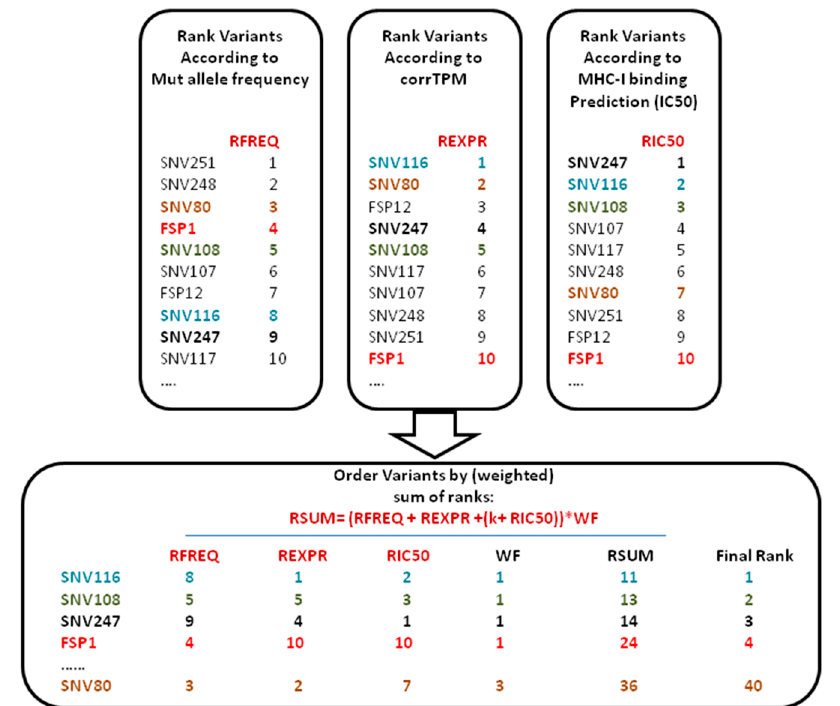
Figure 1. Schematic description of the vaccine-encoded neoantigens unrestricted selection (VENUS) RSUM prioritization method: Schematic description of the ranking procedure applied with VENUS RSUM score. The mutations-encoded neo-peptides are ranked independently three times using three different parameters. For each neo-peptide, the individual ranks are summed and corrected according to weighting factors (k; WF; details in methods) that penalize neo-peptides with a predicted IC50 > 1000 nM (k) and mutations that fall in regions with low read coverage or within not expressed genes according to the next generation sequencing (NGS) mRNA transcriptome data (WF).